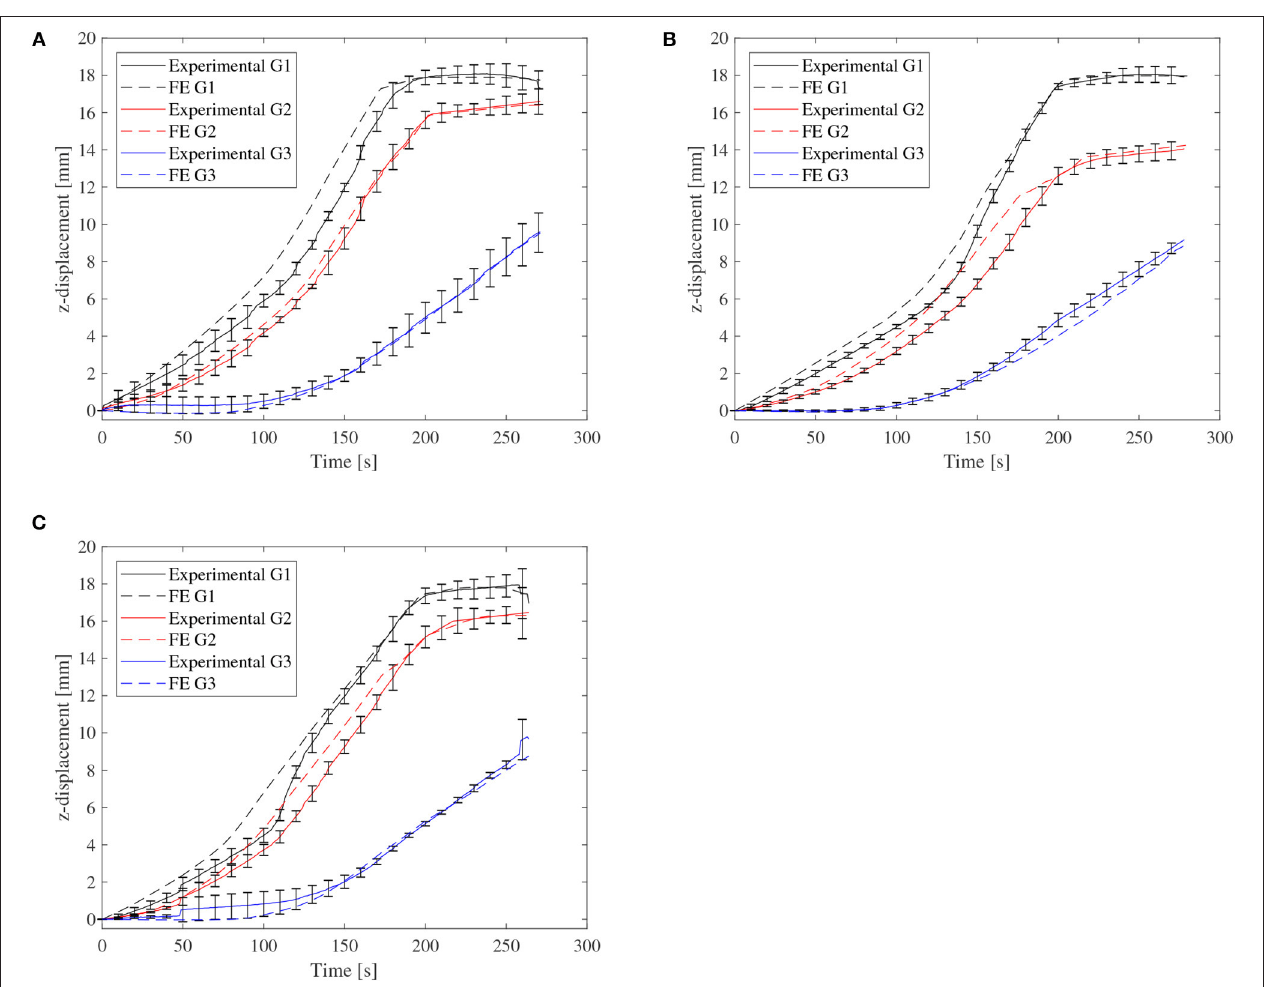
FIGURE 9 | DIC vs. FE displacement at 3 points on the domes, showing: (A) arrow-head, (B) re-entrant, and (C) tri-chiral topologies.